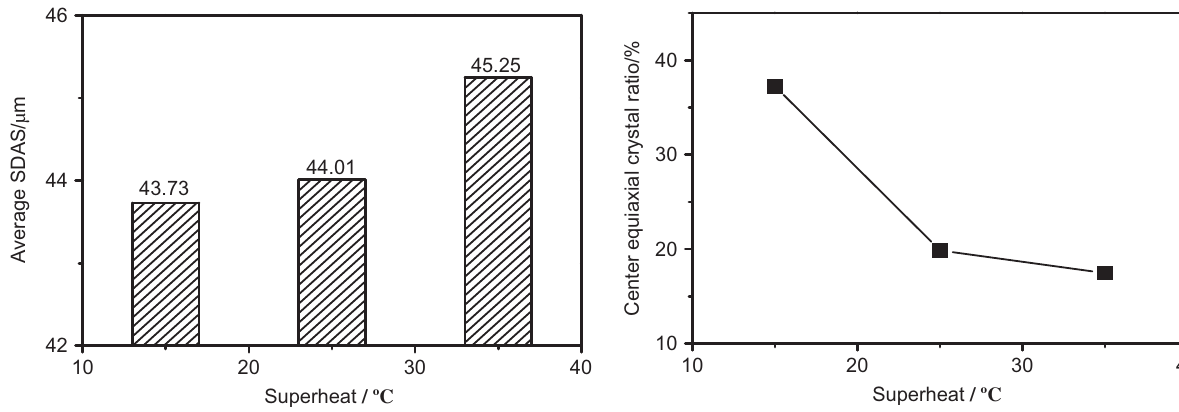
Figure 6: The simulated statistical results of SDAS and equiaxed crystal ratio at different